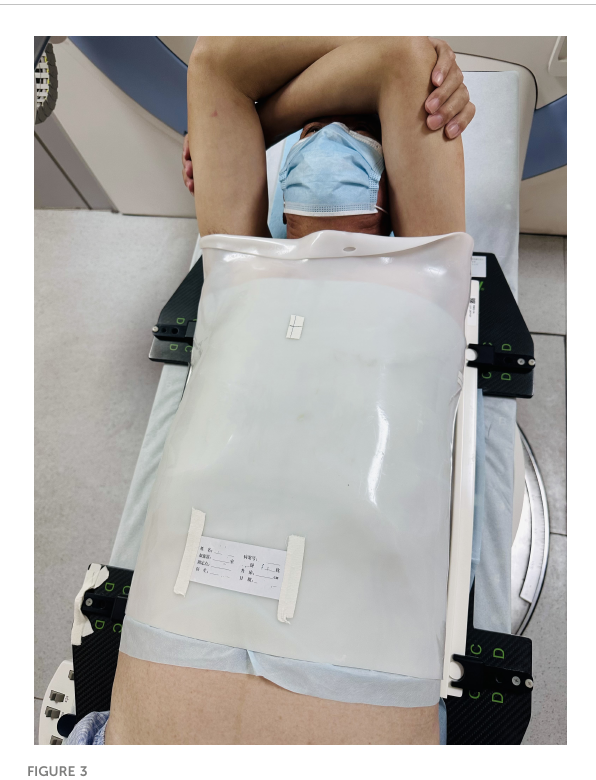
FIGURE 3 Illustration of the setup using the thoracoabdominal fl at immobilization device (TAFID).